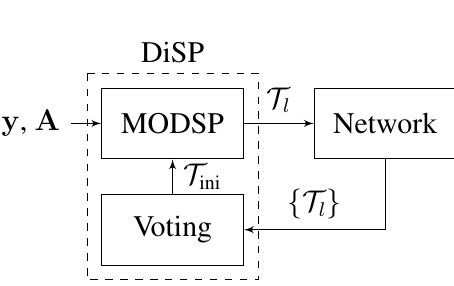
Figure 4. Algorithm